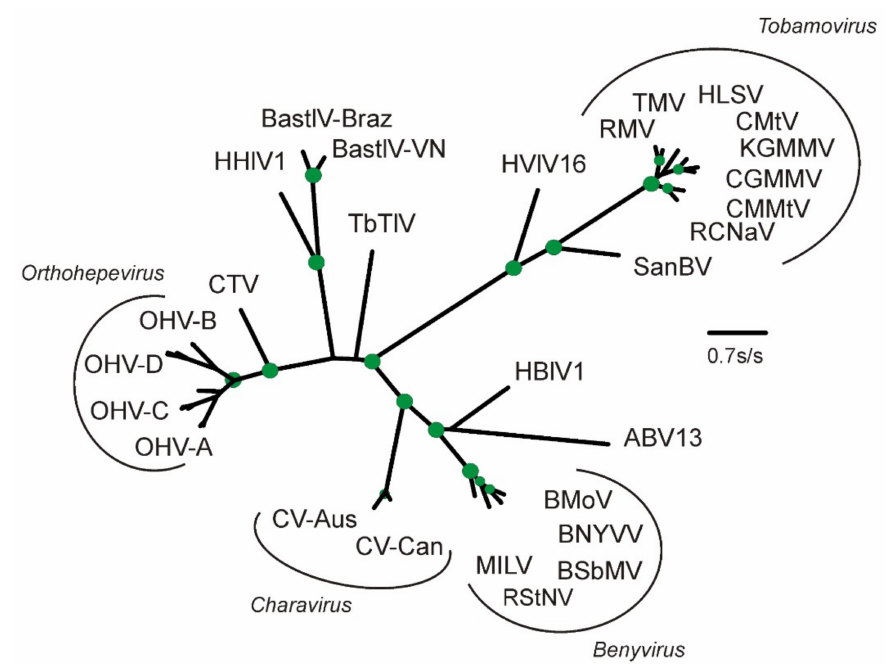
Figure 2. Maximum-likelihood phylogeny of the amino acid sequences of the RdRp-2 regions of the replicase proteins of the charaviruses, benyviruses, and selected tobamoviruses and